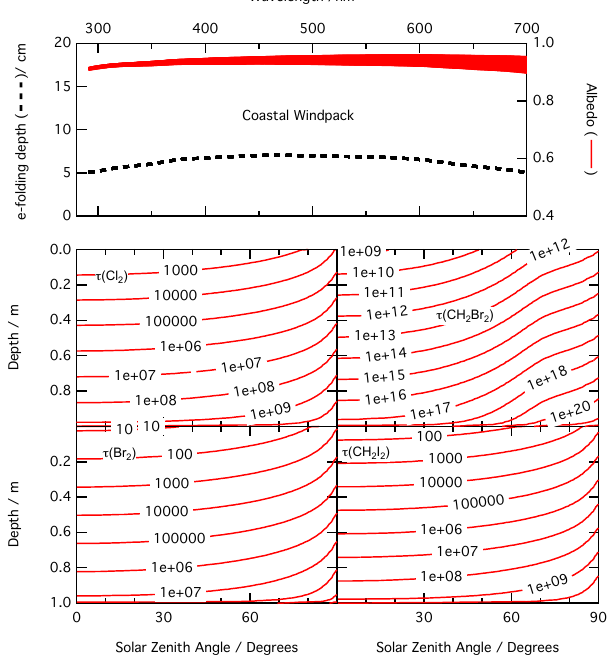
Fig. 3. Upper frame: albedo and e-folding depth for light penetra- tion in a coastal snowpack. Lower frame: photolysis lifetime iso- pleths versus snowpack depth and solar zenith angle for the pho- tolysis of select species in a coastal snowpack. See Supplement for